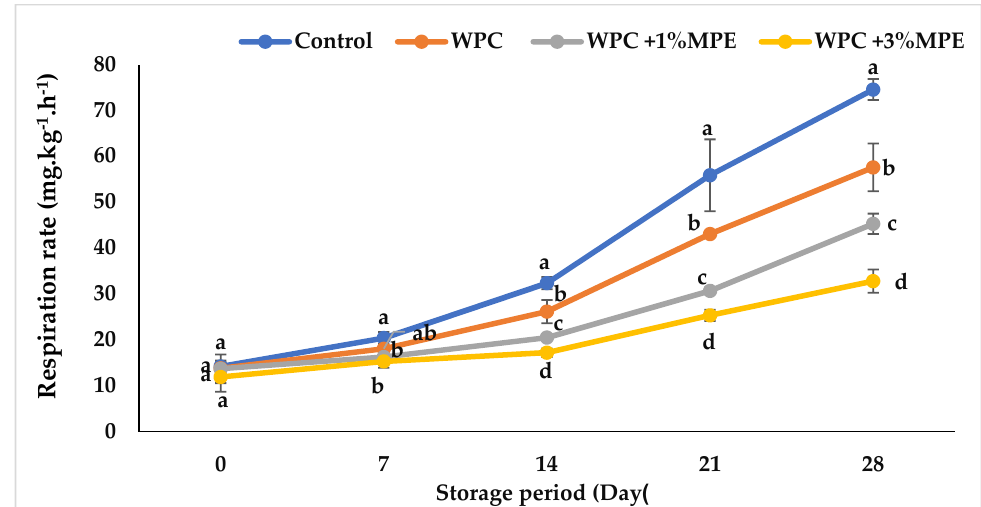
Figure 3. Effect of whey protein concentrate combined with mango peel extract (WPC = whey protein concentrate alone, WPC + 1% MPE = whey protein concentrate + mango peel extract at 1% and WPC + 3% MPE = whey protein concentrate + mango peel extract at 3%) on respiration rate of broccoli fresh-cuts at 5 °C. Vertical bars indicate standard deviation (n = 6). Means and different letters indicate significant difference between treated and control broccoli for each storage period (Duncan’s multiple range test at 95%).